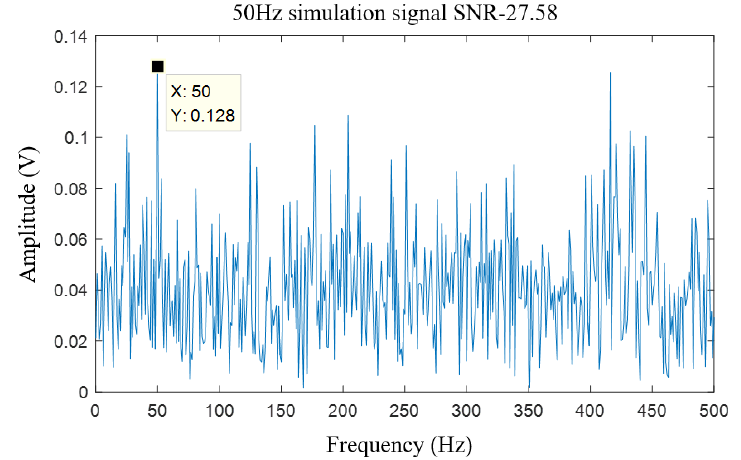
Figure 5. The frequency domain waveform of the original signal.